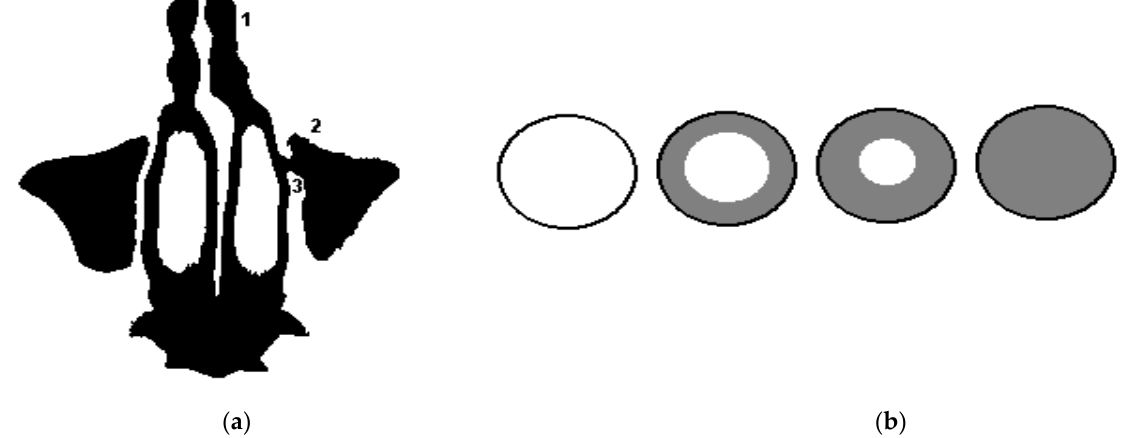
Figure 3. Segmentation of the airways of the nasal cavity according to tomographic data and a schematic illustration of the overlap of the natural anastomosis of the maxillary sinus: ( a ) segmentation of the airways of the nasal cavity according to tomographic data in the axial projection at the level of the middle nasal passage: 1—airways, 2—maxillary sinus, 3—natural anastomosis of the maxillary sinus sinuses (for the left side of the nasal cavity); ( b ) a schematic illustration of the overlap of the anastomosis of the maxillary sinus: from left to right, with a working (unblocked) anastomosis, 60% free, 30% free, and with completely blocked anastomosis.